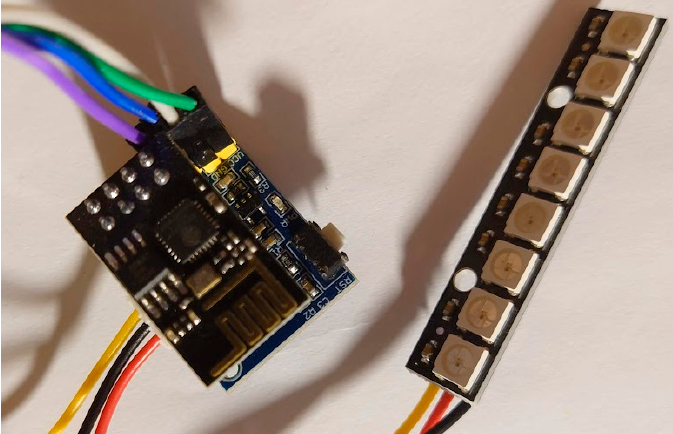
Figure 3. Example of ambient light LED matrix connection with an ESP8266.